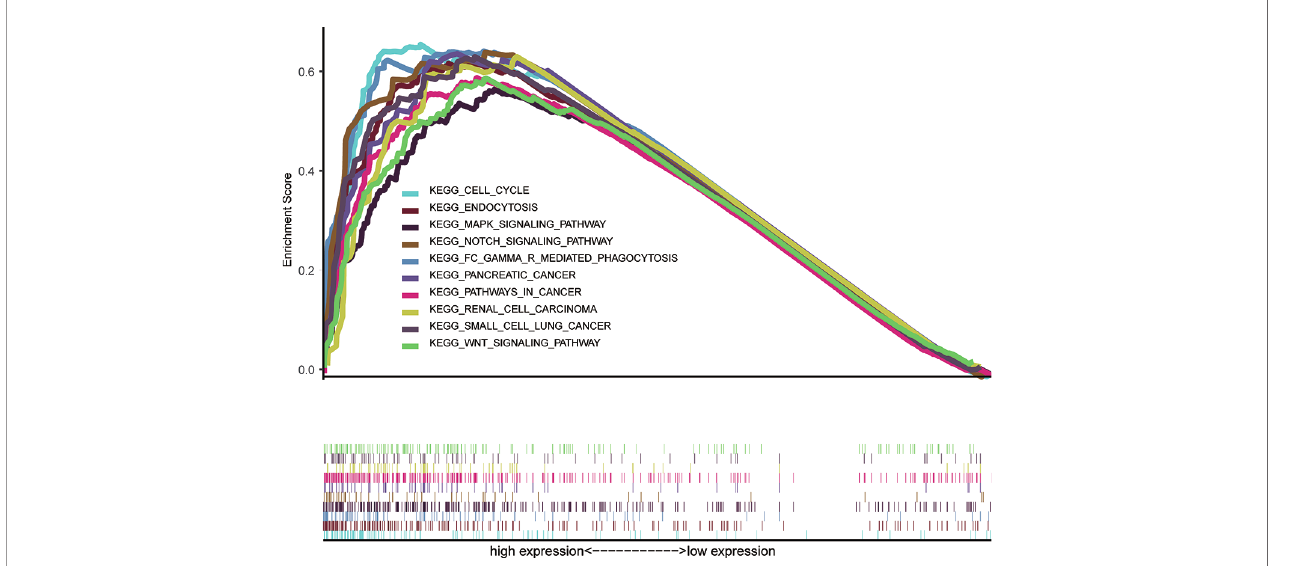
FIGURE 7 | GSEA of the KEGG signaling pathway activated by high expression of FAM57A in HCC. GSEA, Gene set enrichment analysis; KEGG, Kyoto Encyclopedia of Genes and